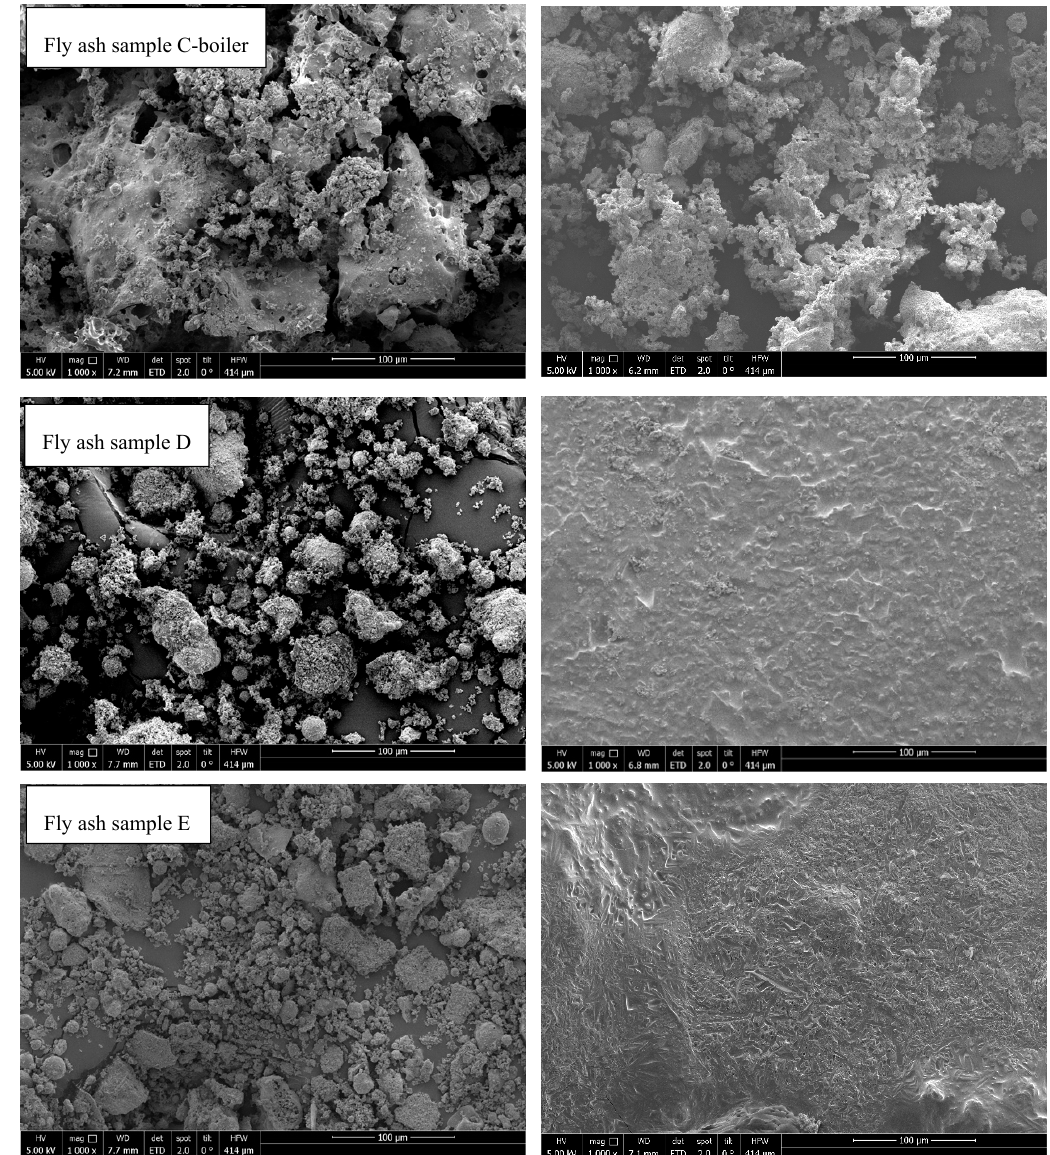
Figure 12. SEM analysis of fly ash samples before (left) and after (right) STA experiments.